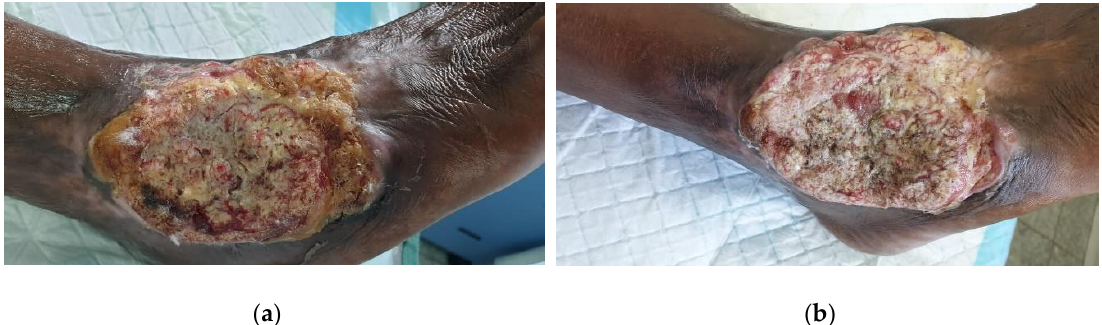
Figure 5. Clinical Case 4 of heavily Pseudomonas -infected wound on the ankle treated with L-Mesitran Soft. ( a ) Picture at start of L-Mesitran Soft treatment on Day 0. ( b ) Clear wound progression after 20 days of